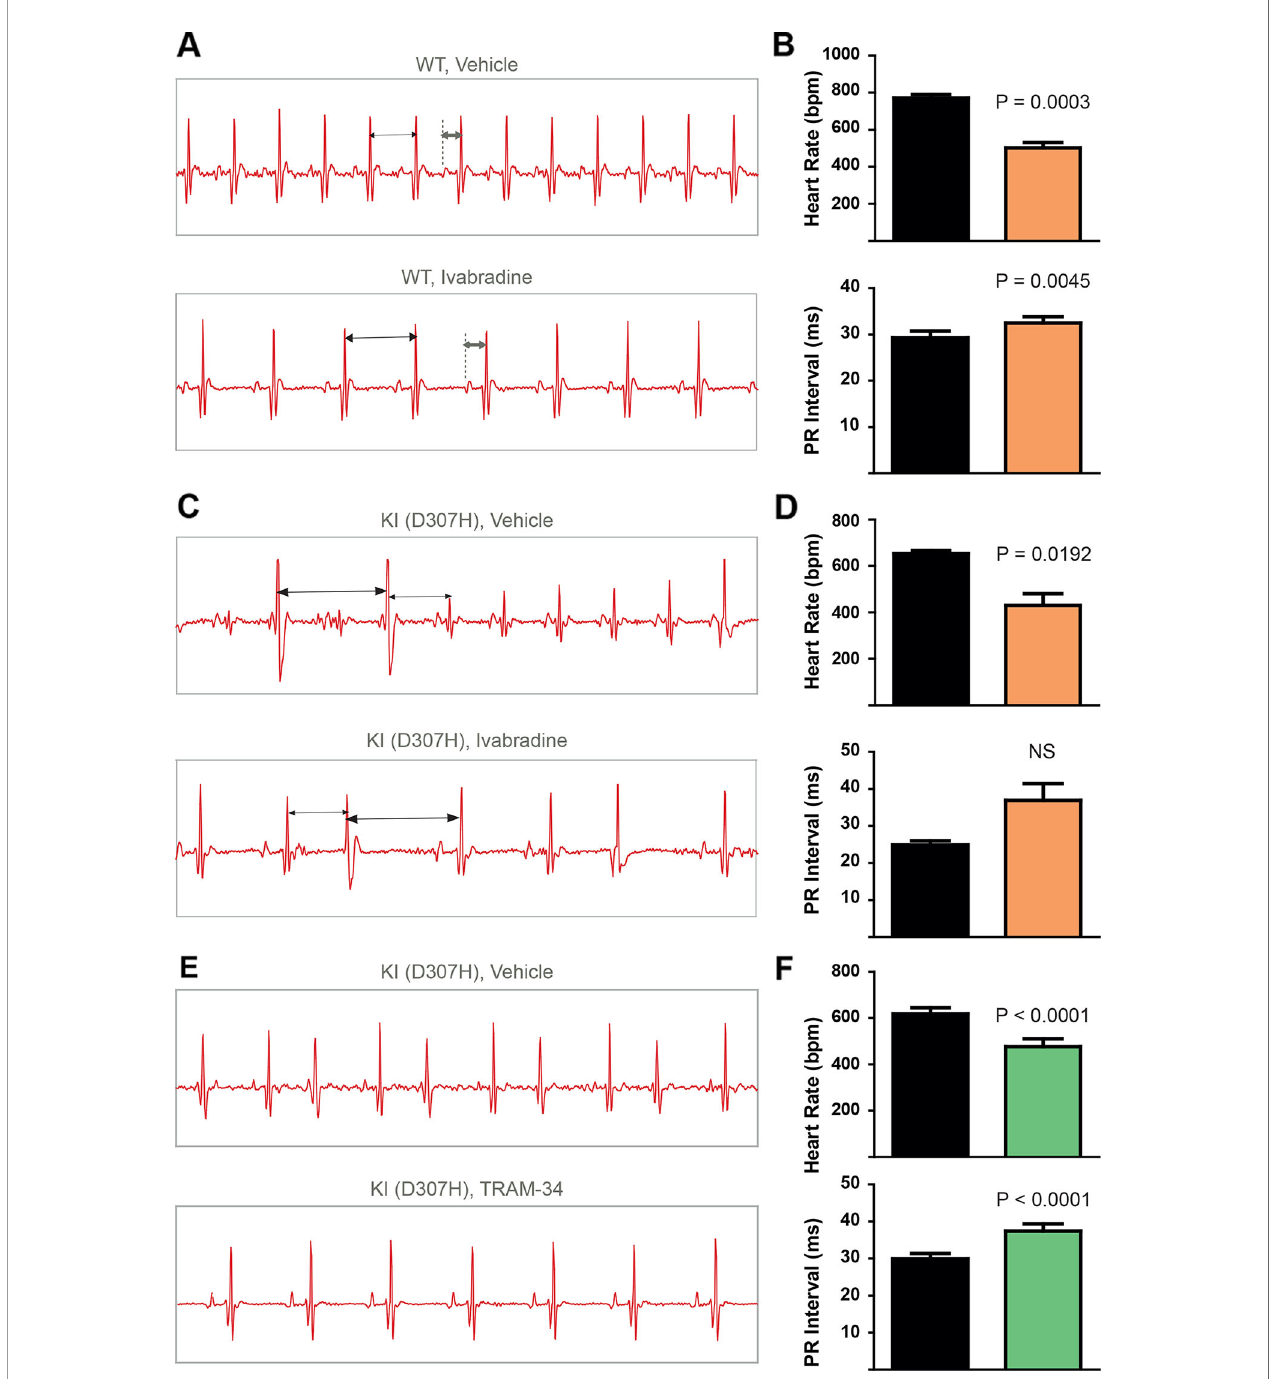
FIGURE 3 | In contrast to TRAM-34, ivabradine does not prevent the ventricular arrhythmias recorded in ECG from CASQ2-D307H KI mice at rest. (A) Representative ECG recording following intraperitoneal (IP) injection of vehicle (saline, upper) and 6 mg/kg ivabradine (lower), in WT mice at rest. Sequential vehicle and ivabradine injections were performed on the same animal. (B) Data summary of heart rate (paired t test, P = 0.0003, n = 4) and PR interval (paired t test, P = 0.0045, n = 4) after IP injection of ivabradine. (C) Representative ECG recordings following IP injection of vehicle (saline, upper) and 6 mg/kg ivabradine (lower) in CASQ2 D307H knock-in (KI) mice at rest. (D) Data summary of the heart rate (paired t test, P = 0.0192, n = 4) and PR interval [not signi fi cant (NS), n = 4] after IP injection of ivabradine. (E) Representative ECG recording following IP injection of vehicle (peanut oil, upper) and 20 mg/kg TRAM-34 (lower) in CASQ2 D307H KI mice at rest. (F) Data summary of heart rate (paired t-test; P < 0.0001, n = 12) and PR interval (paired t-test; P < 0.0001, n = 12) in CASQ2 D307H KI mice at